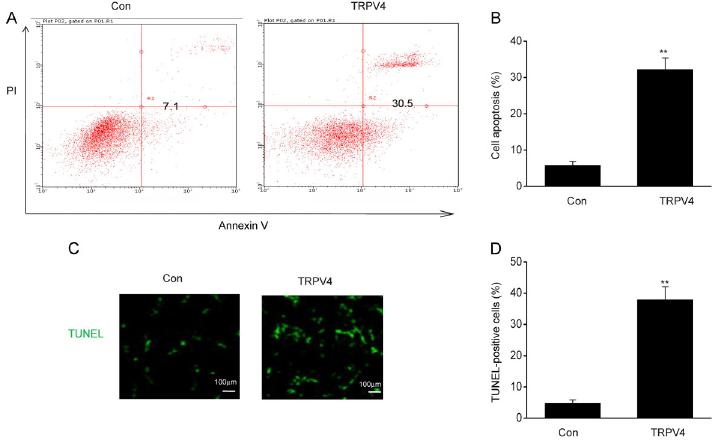
Figure 4. Overexpression of TRPV4 increased death of lung cancer (LC) cell lines. A and B , LC cells A549 were transfected for 24 h with the plasmid pcDNA3( + )/TRPV4 (TRPV4) or the control plasmid pcDNA3.1( + ) (Con). TRPV4 promoted cell death as determined